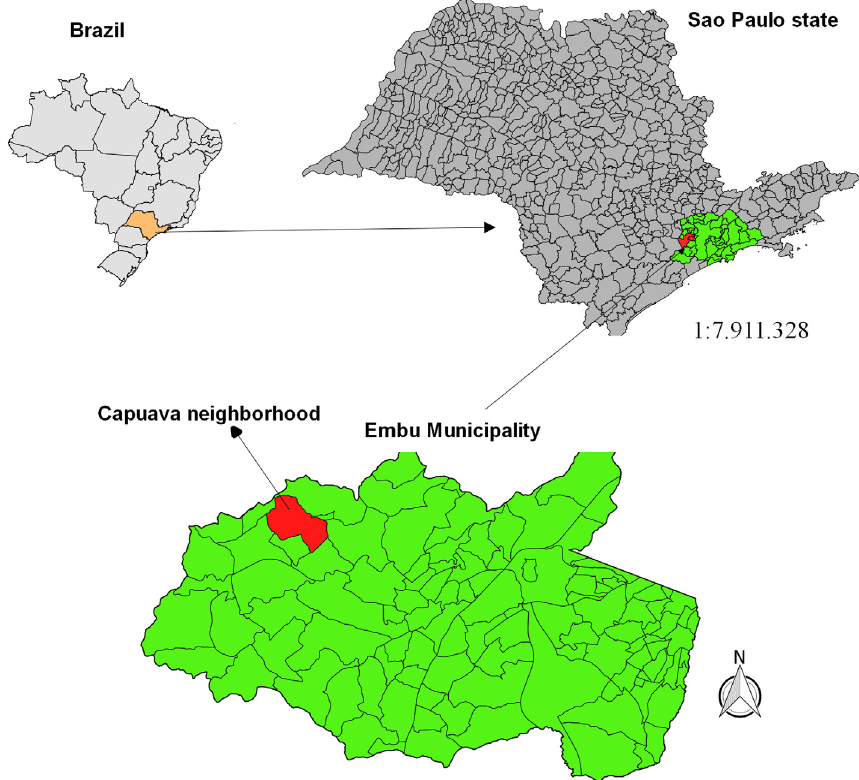
Figure 1. Geographical localization of the study area, Capuava neighborhood, Embu das Artes municipality, São Paulo state,